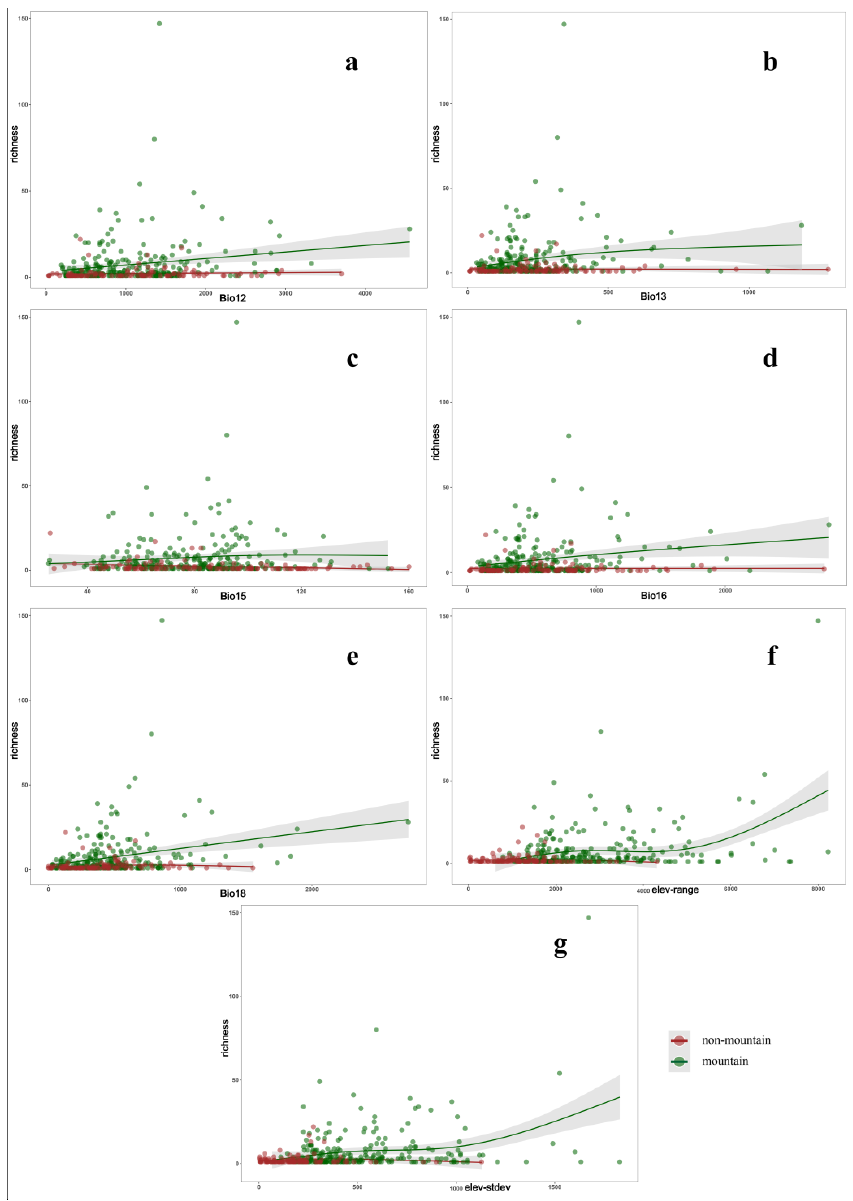
Figure 4. Relationships between richness and environmental factors based on the generalized addi- tive model in the Qinghai-Tibet Plateau and its surrounding area. ( a ) Bio12: Annual Precipitation; ( b ) Bio13: Precipitation of Wettest Month; ( c ). Bio15: Precipitation Seasonality (Coefficient of Varia- tion); ( d ) Bio16: Precipitation of Wettest Quarter; ( e ) Bio18: Precipitation of Warmest; ( f ) Elev-range: elevation range; and ( g ) Elev-stdev: elevation standard deviation. Gray borders around the lines indicate confidence intervals.